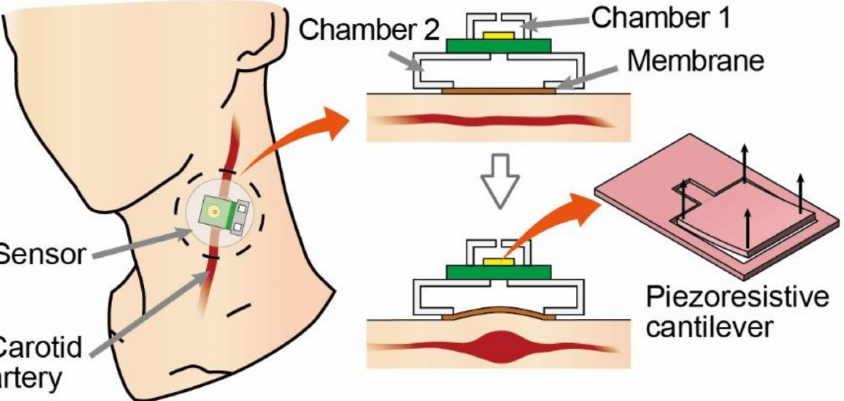
Figure 1. Schematic illustration of pulse wave sensor. Pulse wave sensor is composed of MEMS piezoresistive cantilever and two air chambers. One of the two chambers is pressed against the skin via a membrane to detect vibrations caused by pulse